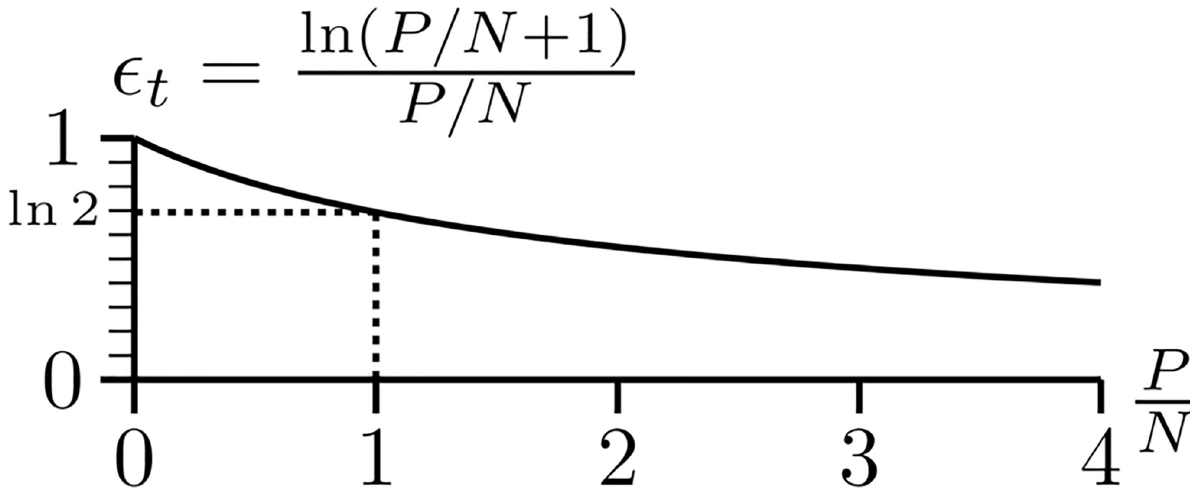
Fig 4. The isothermal efficiency curve (Eq (9)) derived either from information theory and thermodynamics [19, 22, 52] or Gaussian distributions (this paper). Shannon’s channel capacity theorem [21] ensures that no system can lie above the curve.